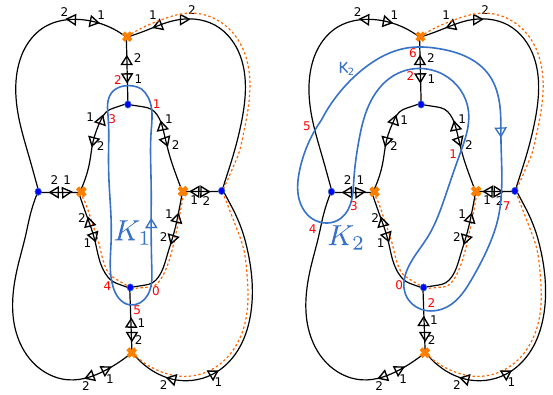
( e C; Z ) with representative 1